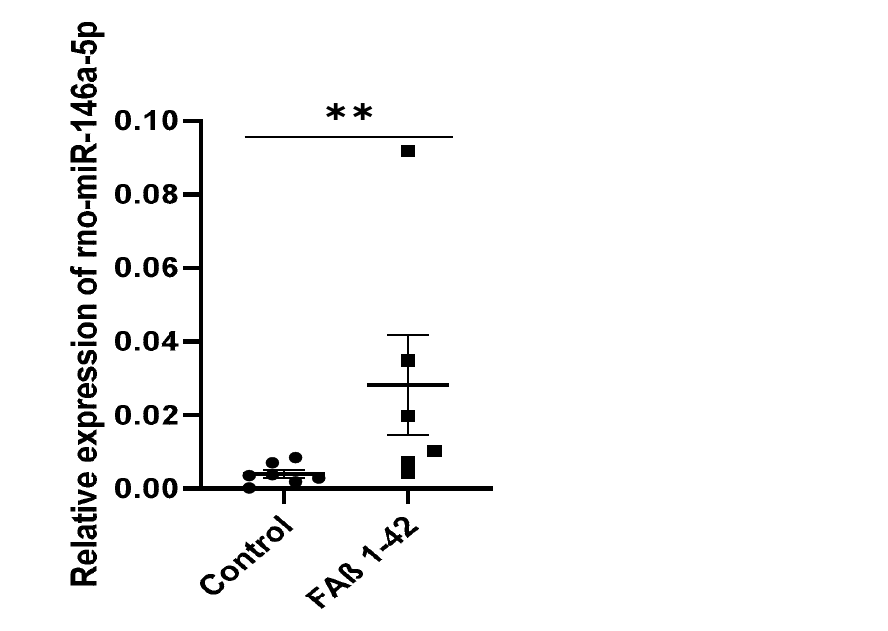
Figure 7. Relative expression of circulating miRNA-146a-5p in CSF of rats infused with FA β 1–42 peptides solution. CSF samples from rats infused with FA β (2.5 µ g/ µ L) or PBS solutions were collected at 14 days post-injection. The amount of miR-146-5p was then quantified by qRT-PCR. Data are represented as mean ± SEM of n = 7 samples performed in triplicate. Statistical comparisons between the FA β -infused and control group were performed using the Mann–Whitney test. ** p ≤ 0.01.